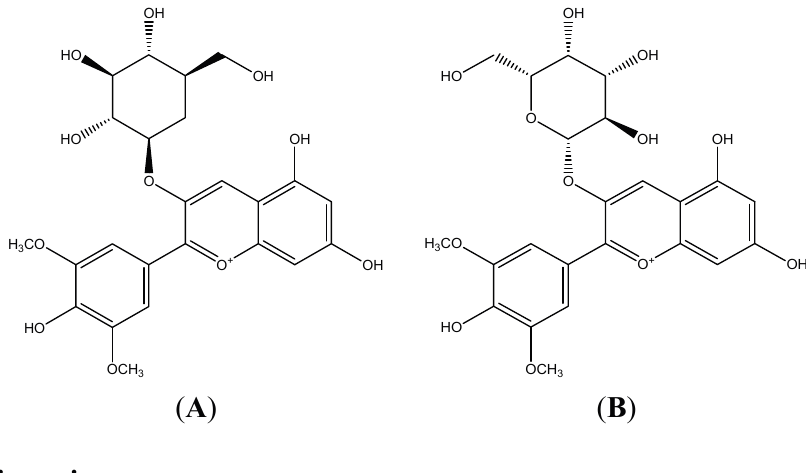
Figure 1. The structures of malvidin-3-glucoside ( A ) and malvidin-3-galactoside ( B